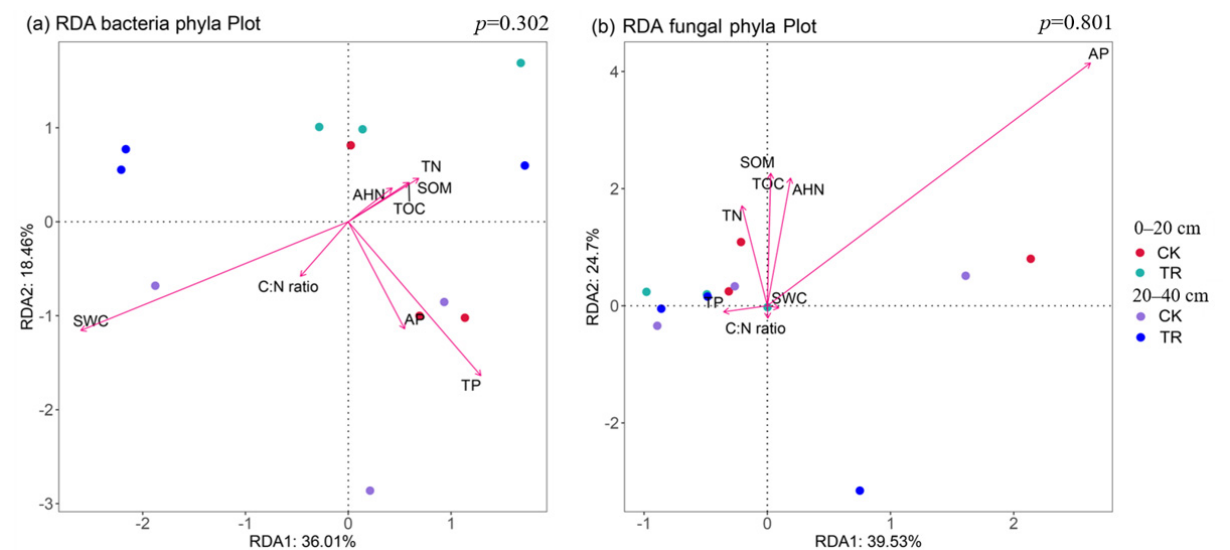
Figure 5. The biplot of redundancy analysis illustrated the relationships between bacterial ( a ) or fungal ( b ) community and the soil physicochemical properties. TN = total nitrogen, TP = total phosphorus, AHN = alkali-hydrolyzed nitrogen, AP = available phosphorus, C:N ratio = ratio of total organic carbon and nitrogen, SWC = soil water content, TOC = total organic nitrogen, SOM = soil organic matter.